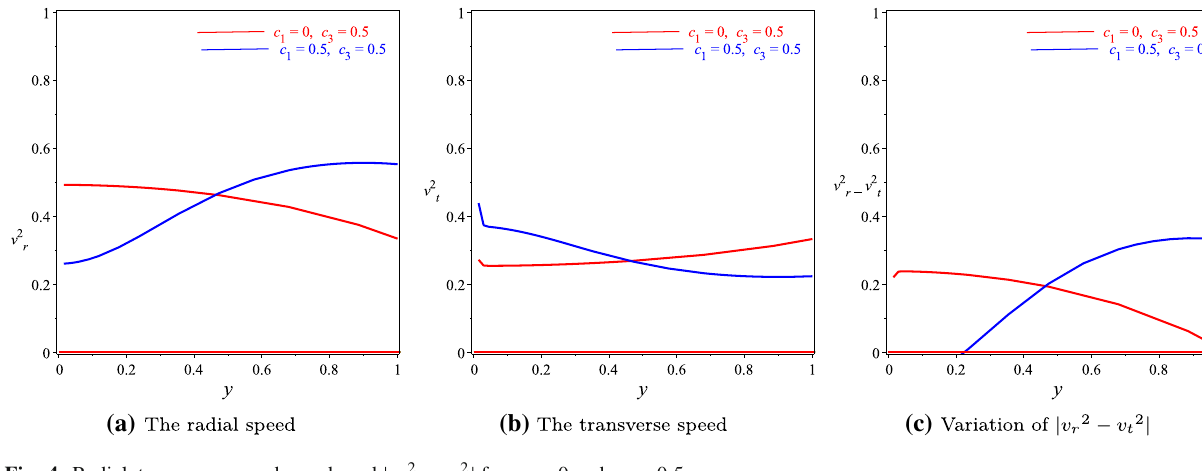
Fig. 4 Radial, transverse sound speeds and | v r 2 − v t 2 | for c 1 = 0 and c 1 = 0 . 5